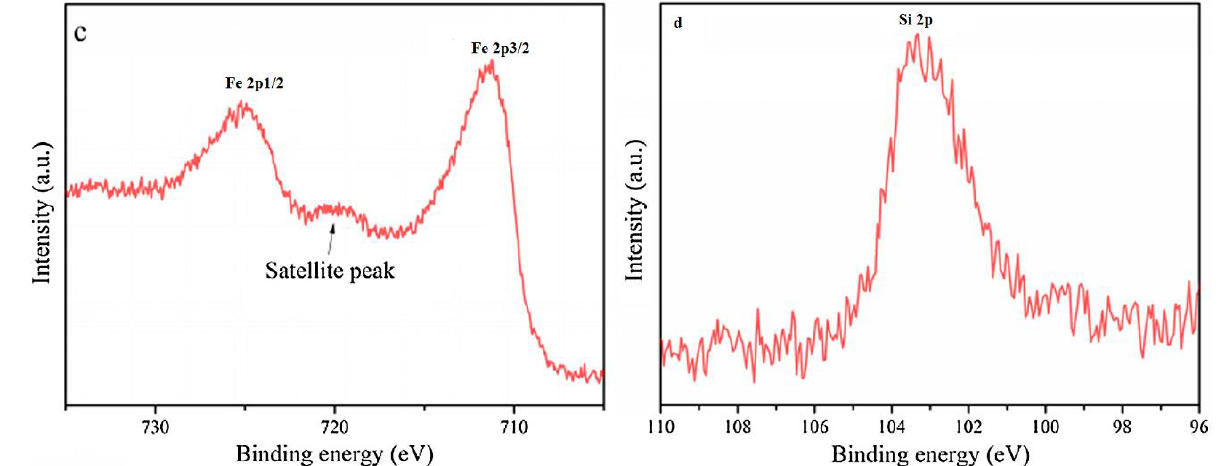
Figure 3. XPS spectra of catalysts: ( a ) Survey spectrum, ( b ) Ti 2p spectrum, ( c ) Fe 2p spectrum, ( d ) Si 2p spectrum. Table 1. Chemical composition of the samples of bentonite and Fe 2 O 3 /B/TiO 2 (mass %).